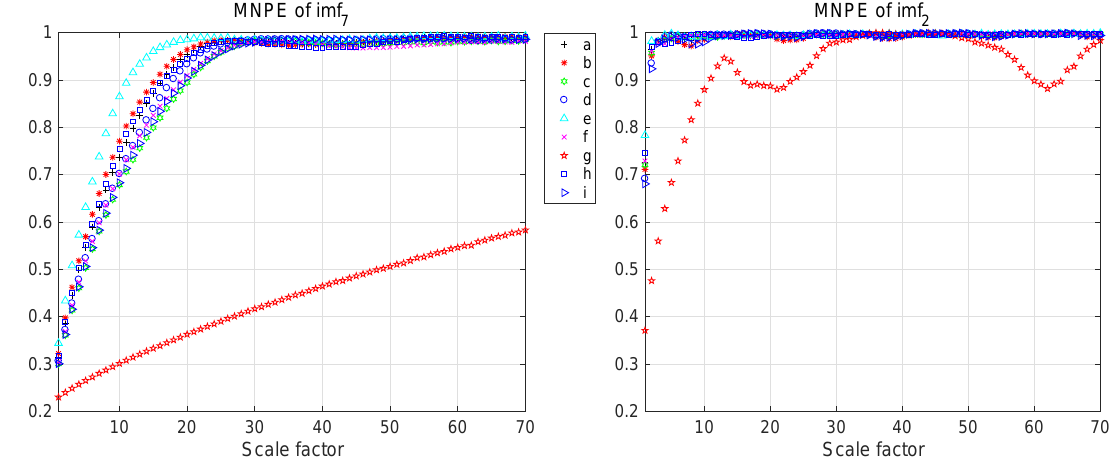
Figure 9. MNPE features comparison of imf 7 and imf 2